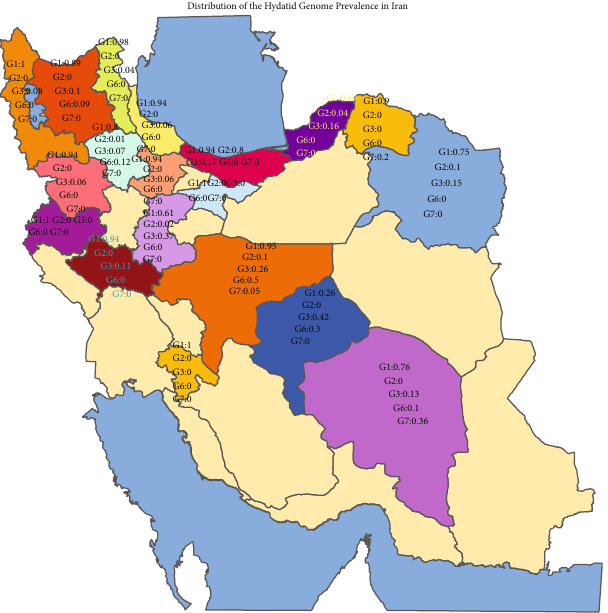
Figure 2: Distribution of di ff erent types of cystic echinococcosis genotypes in Iran.